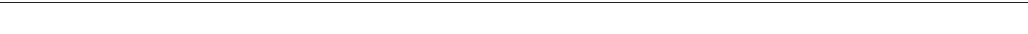
Fig. 1 HUWE1 cooperates in AMBRA1-mediated mitophagy. a Table showing the E3 ubiquitin ligase interacting with AMBRA1 upon mitophagy stimuli in HeLa PARKIN-free cells. The ratio of heavy labelled peptides to the remaining non-labelled ones (ratio H/L) re fl ects is indicated. b Representative image of AMBRA1 ActA -HUWE1 co-immunoprecipitation (Co-IP); n = 3. c Representative image of AMBRA1 WT -HUWE1 co-immunoprecipitation (Co-IP) upon mitophagy stimulation (O/A); n = 3. d PcDNA3 or Myc-AMBRA1 ActA transfected HeLa cells were subjected to mitochondria – cytosol puri fi cation. Samples were blotted for the indicated antibodies; n = 3. e PcDNA3 or Myc-AMBRA1 WT transfected HeLa cells were treated with O/A for 30 min and subjected to mitochondria – cytosol puri fi cation; n = 3. f HeLa cells transfected with PcDNA3 or Myc-AMBRA1 ActA vectors were transfected with siRNA-Ctr or